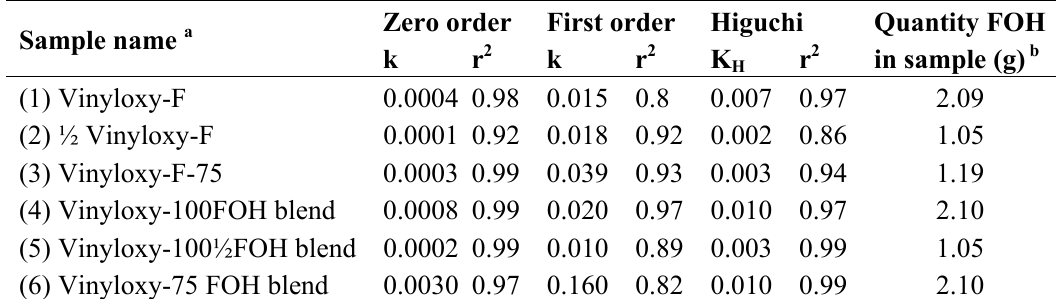
Table 3. Analysis of kinetic rates for fluorine modified systems.